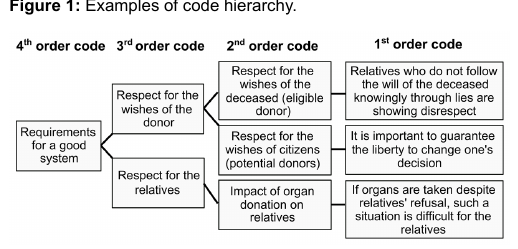
Figure 1: Examples of code